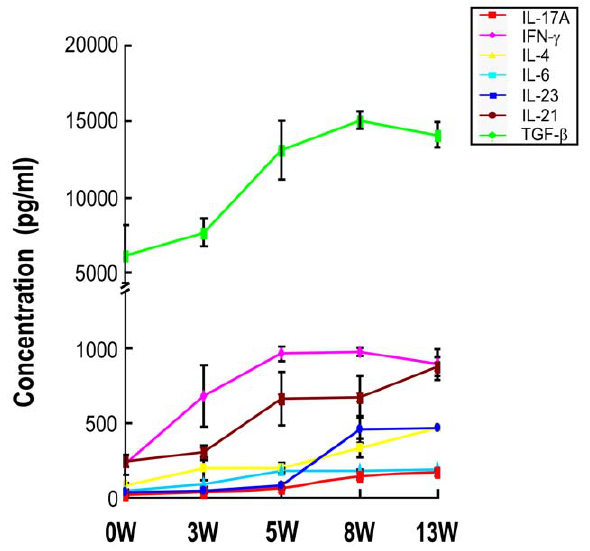
Figure 2. Kinetics of cytokines in the supernatant produced by splenocytes from S.japonicum infected mice. For each of three independent experiments, 20 female C57BL/6 mice were infected with 12 cercariae of S. japonicum per mouse. At 0 (before infection), 3, 5, 8 and 13 weeks post-infection, four mice at each time point were randomly chosen and sacrificed. Single cell suspensions of splenocytes were prepared and then cultured in the presence of PMA and ionomycin. The culture supernatants were collected after 72 h of incubation for detection of IL-17, IFN- c , IL-4, TGF- b , IL-6, IL-23 and IL-21 by ELISA. Data are expressed as the mean 6 SD of 12 mice from three independent experiments.